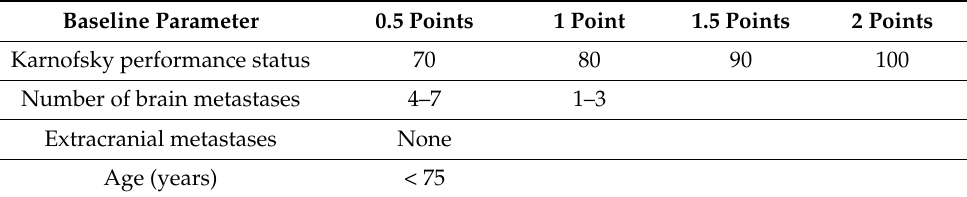
Table 1. Calculation of the point sum that determines prognostic group. Worst prognosis (0 points): Karnofsky performance status <60 and >7 brain metastases and presence of extracranial metastases and age ≥ 75 years. Worst prognostic class: 0–1 points (other classes: 1.5–2 points, 2.5–3 points, 3.5–4